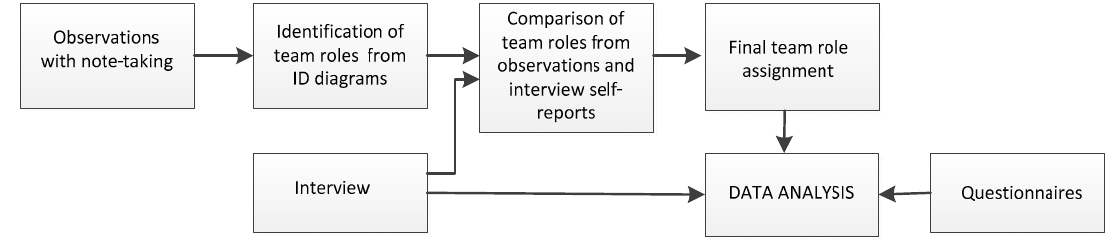
Figure 2. Sequence of research methodology.